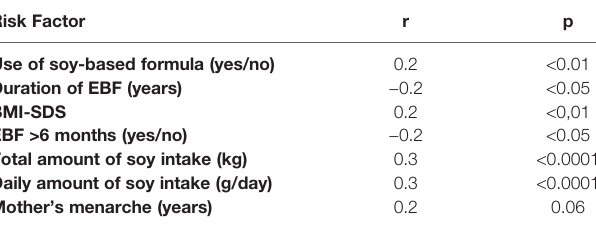
TABLE 3 | Correlations between presence of CPP and risk factors in girls.